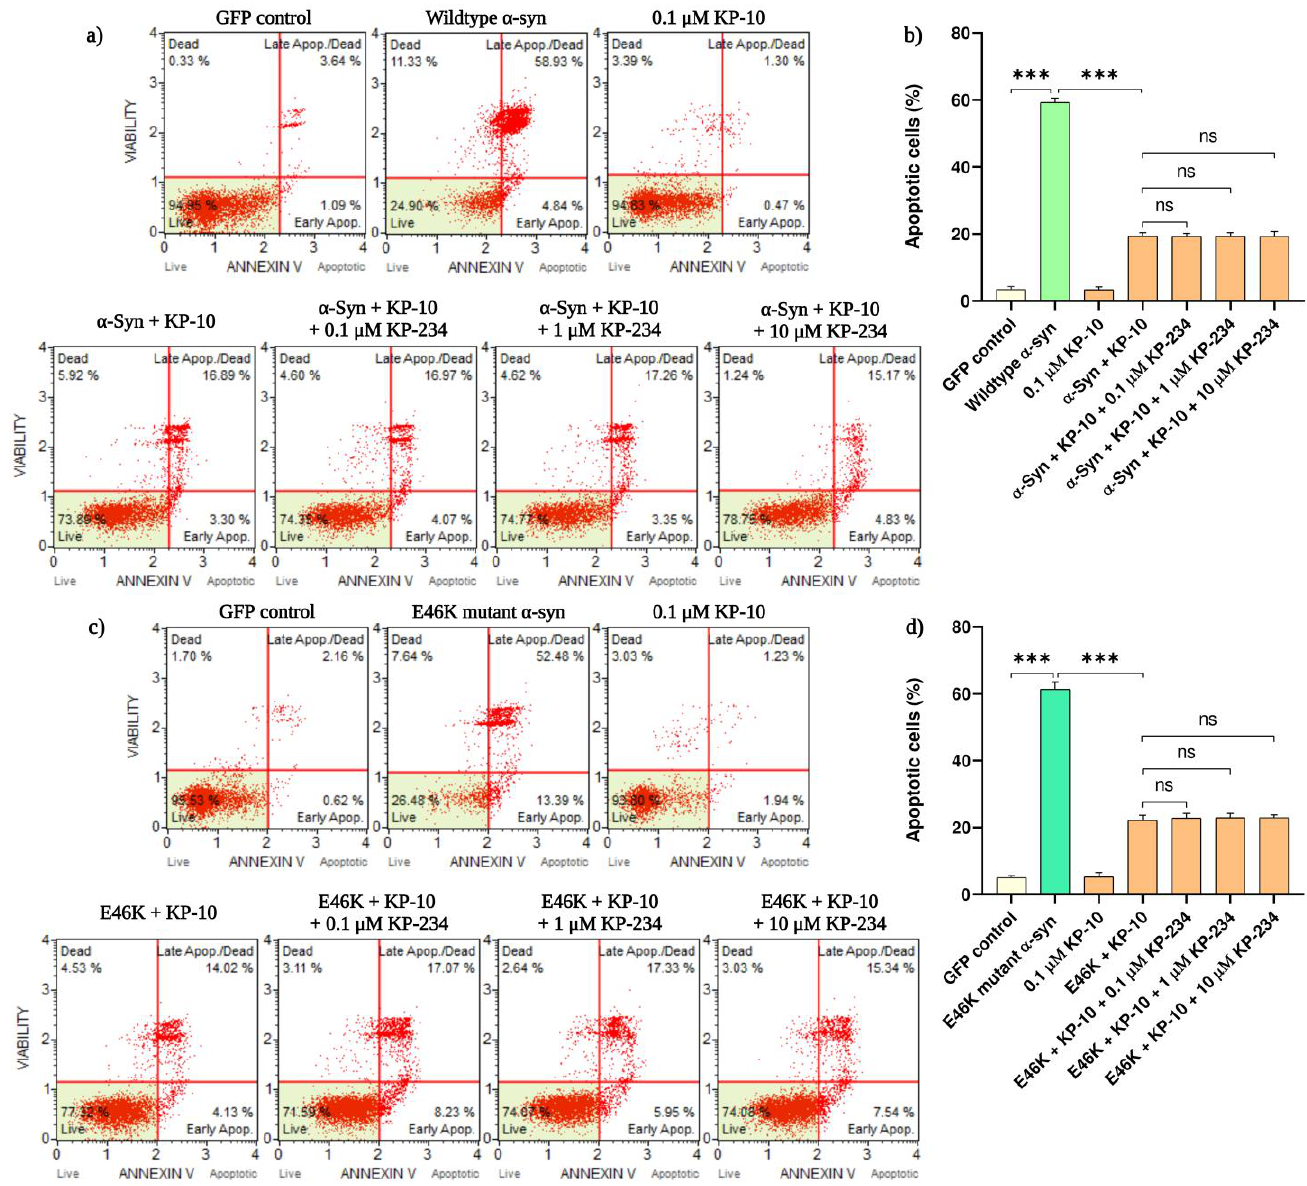
Figure 1. The effect of kisspeptin-10 (KP-10) on human wild-type or E46K mutant α -synuclein ( α -syn)-induced apoptosis in cholinergic-like neurons. Differentiated neurons overexpressing human wild-type or E46K mutant α -syn were exogenously administered with KP-10 (0.1 µ M) either alone or in combination with KP-234 (0.1 to 10 µ M). The induction of apoptotic death was measured using the Muse automated cell analyzer. ( a , c ) Representative plots of experiments executed for annexin-V detection showing non-apoptotic live ( lower left : 7-AAD negative, apoptosis negative), non-apoptotic dead ( upper left : 7-AAD positive, apoptosis negative), apoptotic live ( lower right : 7-AAD negative, apoptosis positive), and apoptotic dead ( upper right : 7-AAD positive, apoptosis positive) cells. The quantification of total apoptotic cells presented in ( b , d ) is representative of mean values ± SEM from three independent biological replicates performed in triplicates. While the externalization of plasma membrane phosphatidylserine by both human wild-type ( a , b ) and E46K mutant ( c , d ) α -syn was considerably inhibited by KP-10 (*** p < 0.001), co-administrations with KP-234 had no discernible impact on this ameliorative effect. Statistical significance was defined as p -value less than 0.001 (*** p < 0.001).